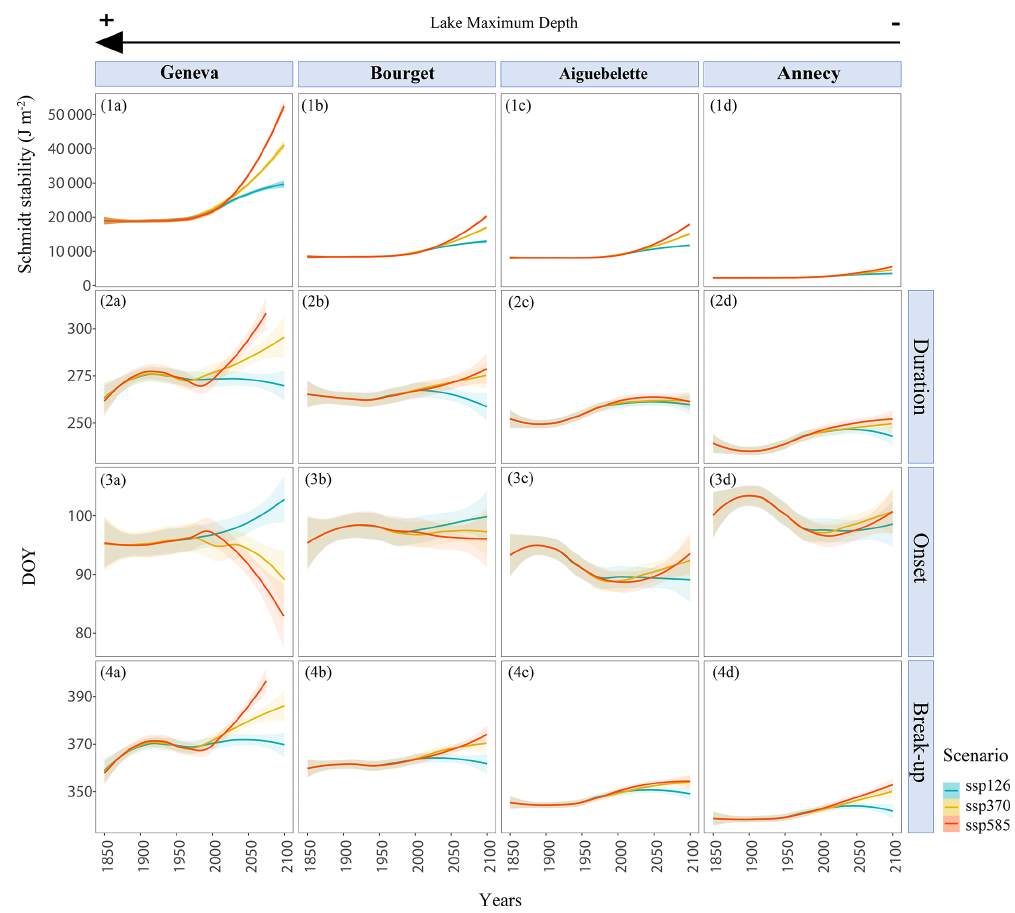
Figure 7. Stratification trend characteristics for the four lakes – Geneva (a) , Bourget (b) , Aiguebelette (c) , and Annecy (d) . Estimations of Schmidt stability (1) from June to September, stratification duration (2), onset (3), and breakup (4) over the period 1850–2100 for the three scenarios (SSP126, SSP370, and SSP585), calculated from MyLake water temperature